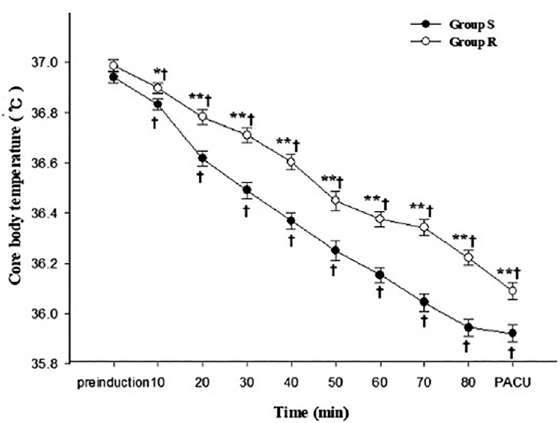
Figure 2. Core body temperature changes were measured in the nasopharynx (during surgery) and tympanic membrane (pre-induction and PACU). PACU, post-anesthesia care unit. Data are presented as estimated mean ± SE. * p < 0.05 vs. group S, ** p < 0.01 vs. group S, † p < 0.01 vs. pre-induction. Patients’ MAP ( p = 0.024) and HR ( p = 0.025) were significantly higher in group R